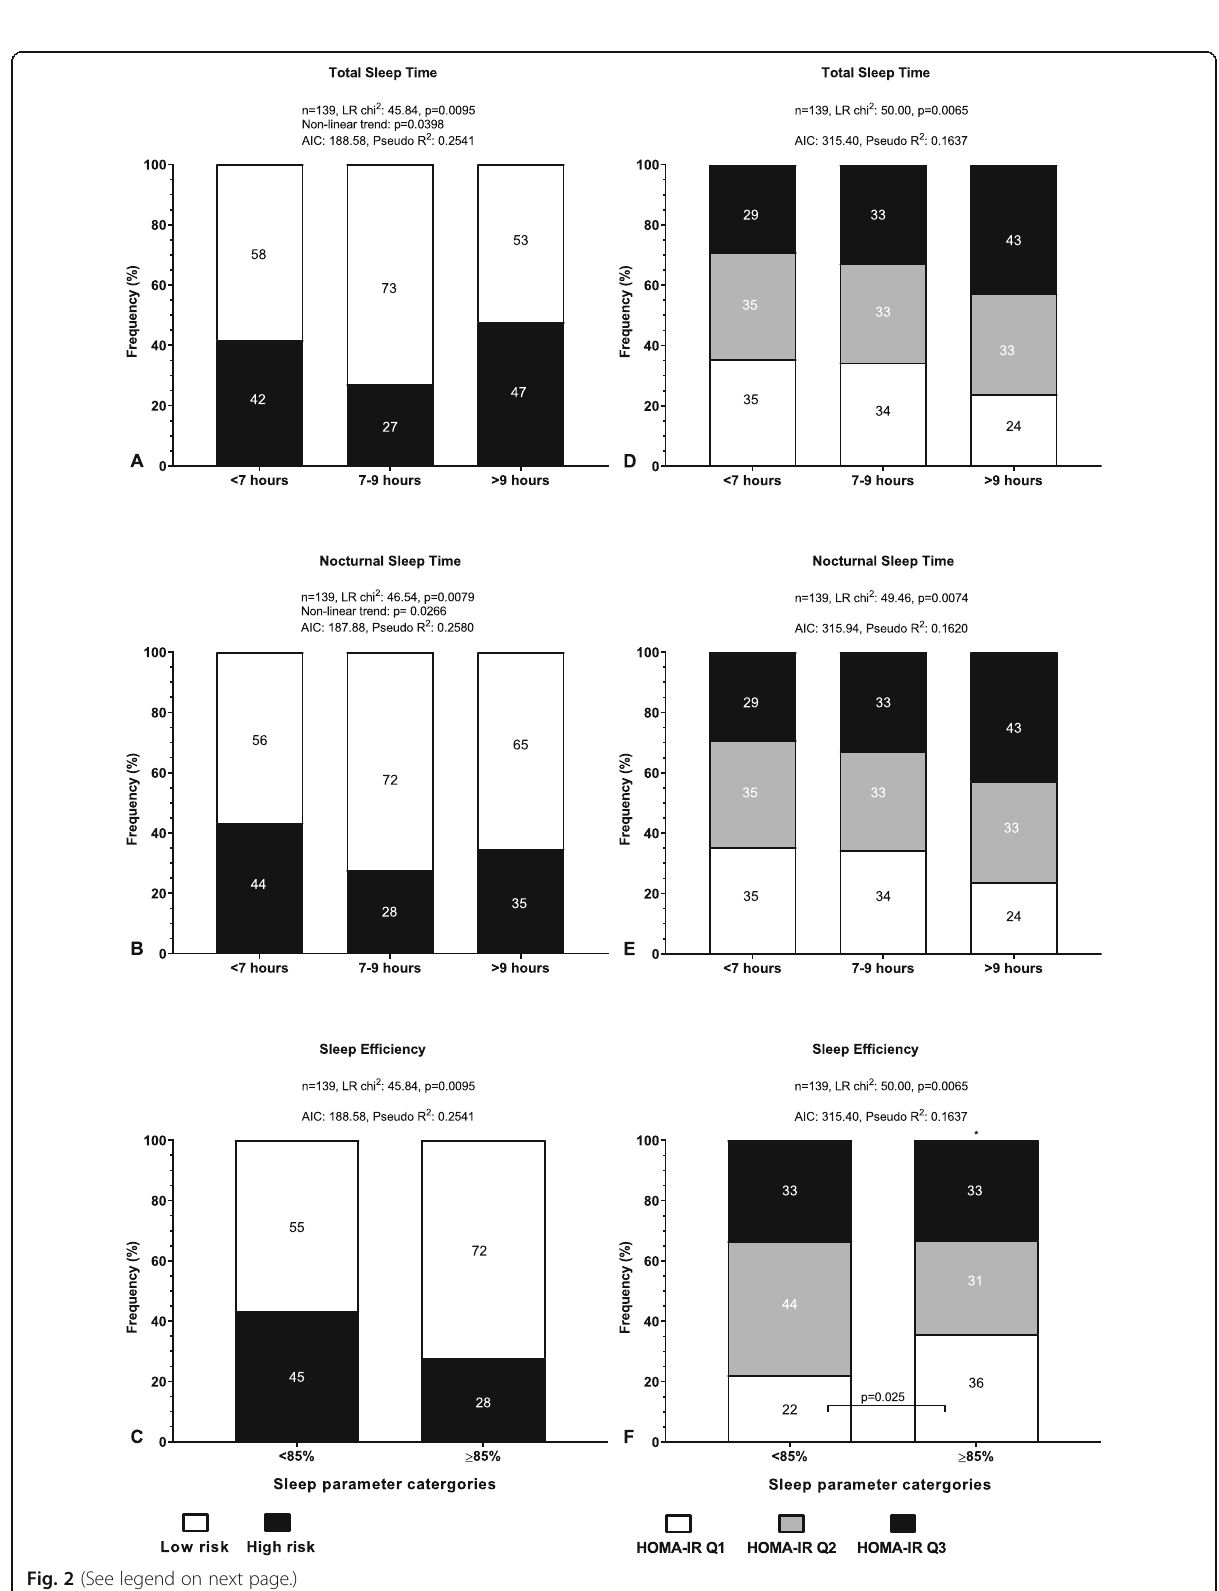
Fig. 2 (See legend on next